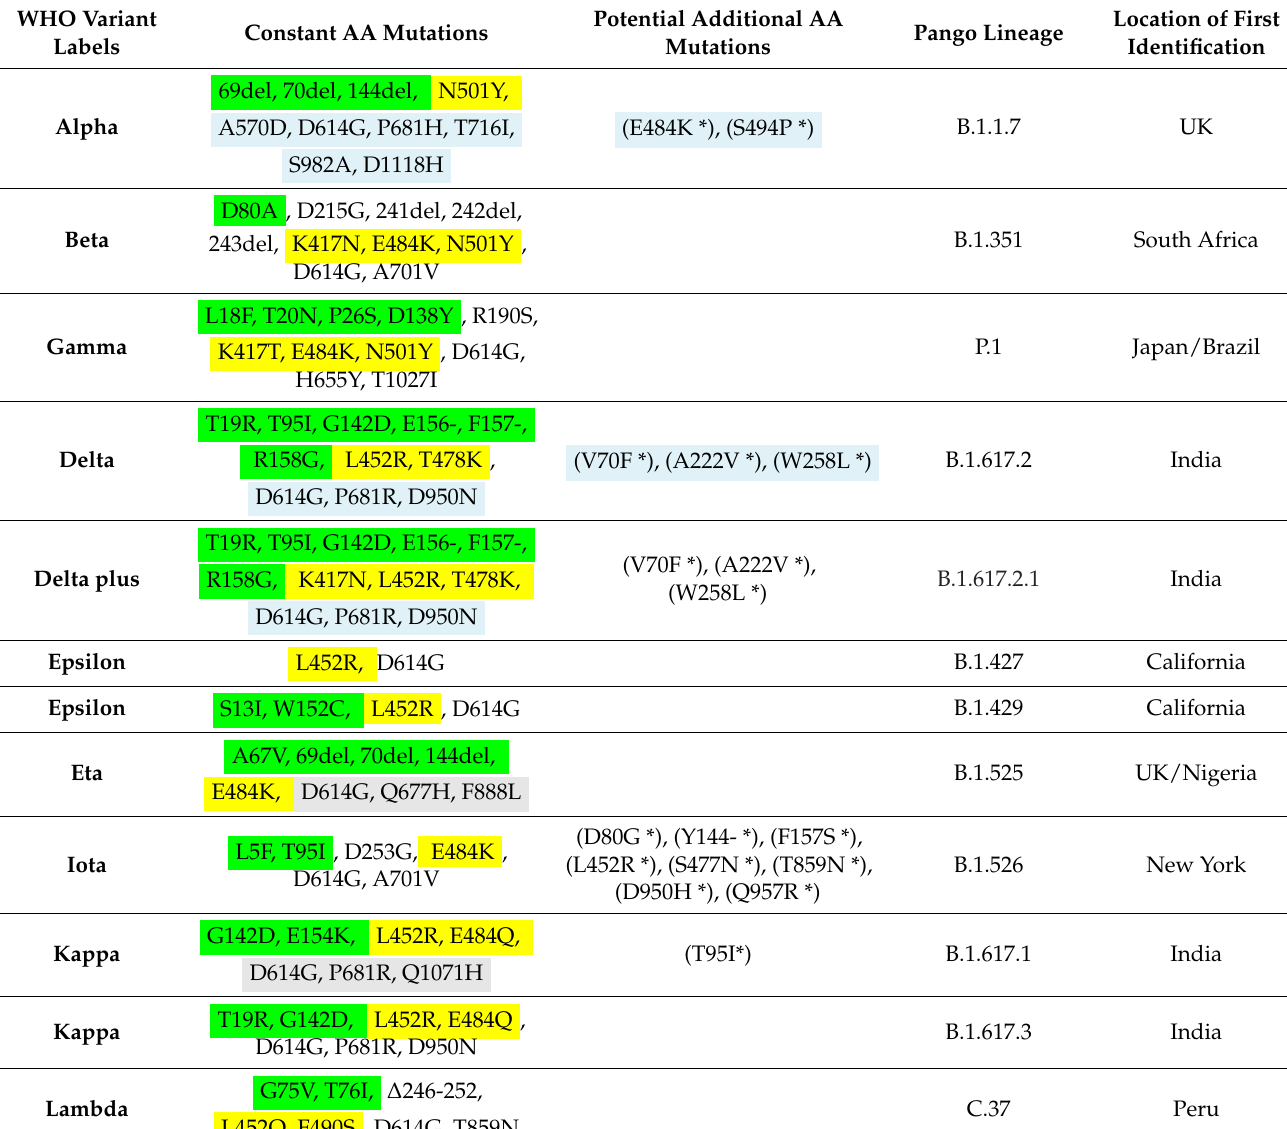
Table 1. CDC’s classification of VOCs and VOIs based on S protein amino acid (AA) mutations. WHO